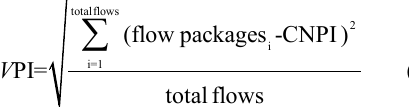
Figure 6. Features of CNPI for Violence Traffic flow